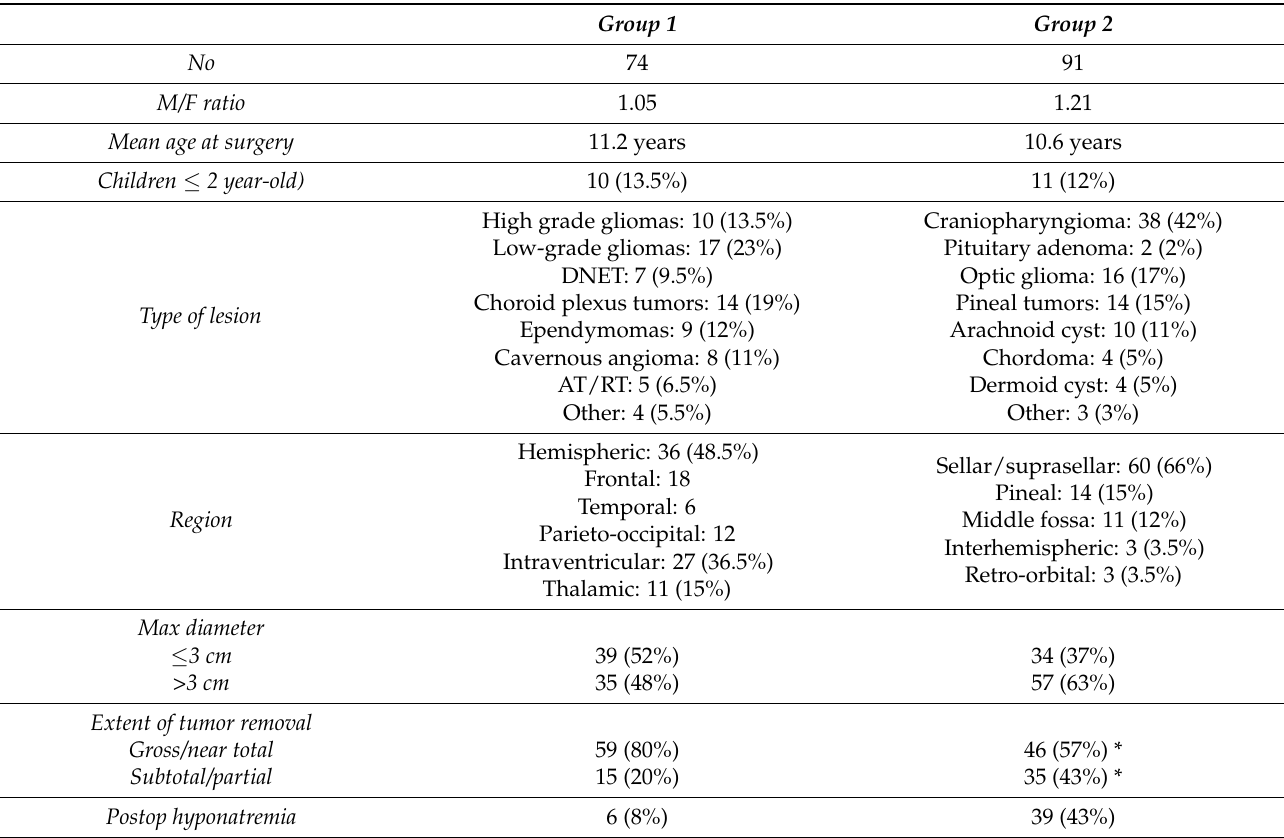
Table 1. Main findings in the two